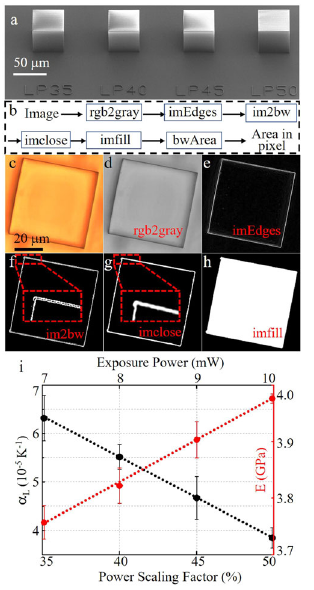
Fig. 2 CTE and Young ’ s modulus measurement. a Bulk polymer cubes written by different laser power scaling factors. b Outline of the general process in ImageJ to obtain areas measured in pixels: the optical image of a polymer cube in panel ( c ) is fi rst converted into 8-bit format in panel ( d ). Then an edge detection algorithm is applied and the image is converted into a binary image in panel ( e ). After applying closing algorithms in panel ( f ) and fi lling algorithms in panel ( g ), we fi nally obtain the internal area de fi ned by these edges in panel ( h ). i The CTE versus laser exposure power is obtained by measuring areas before and after heating. The Young ’ s modulus depicted in red is measured by Brillouin light scattering metrology. The bottom horizontal axis gives the power scaling factor whereas the top horizontal axis gives the actual power. We add black (red) error bars to indicate standard deviations of the calculated CTE (Young ’ s modulus). The CTE decreases (Young ’ s modulus increases) with the laser exposure power. Both variations are approximately linear.